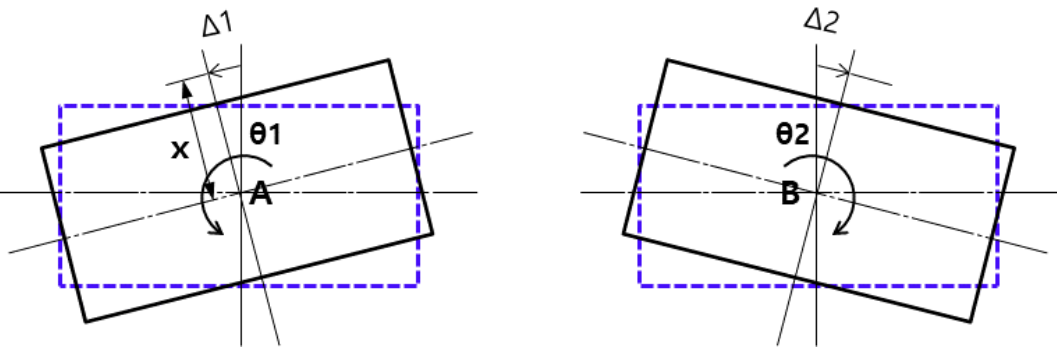
Figure 3. Relative displacement between car body and bogie.